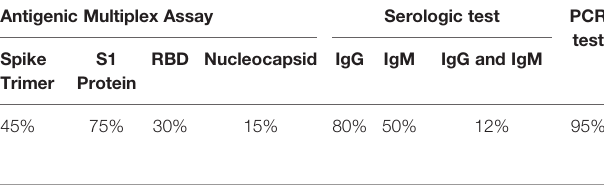
TABLE 1 | Data summary of cohort 1 for SARS-CoV-2 Antigen Pro fi